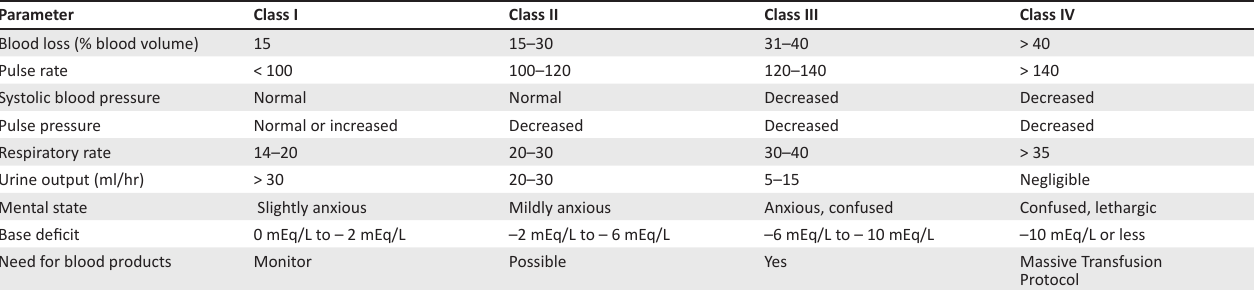
TABLE 1: Classification of haemorrhagic